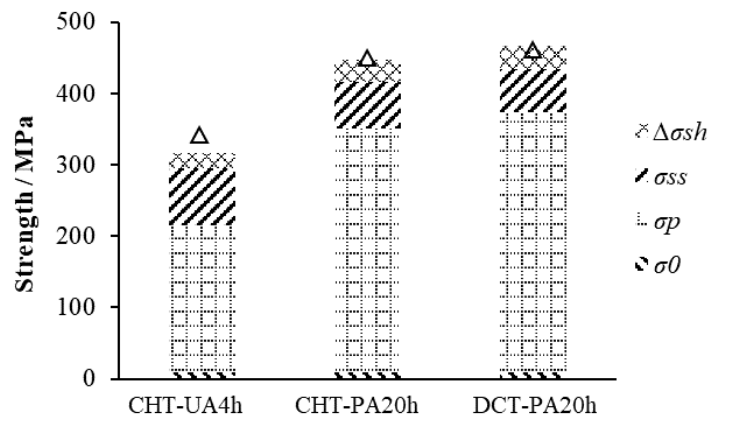
Figure 11. Comparison of the yield strength contributions in the samples under different heat treat- ment from calculations. (The experimental data are plotted as symbols in the figure for